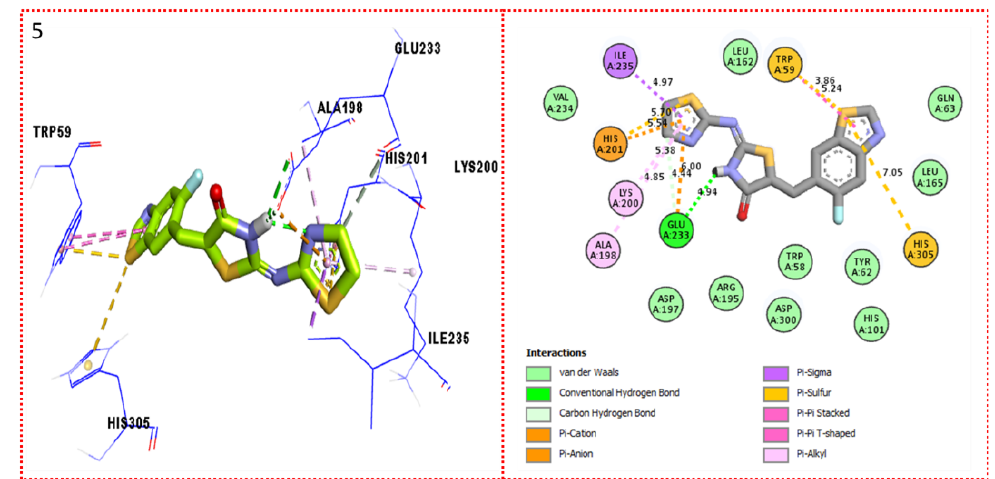
Figure 9. Protein – ligand interaction profile for active analogue against α‐ amylase represents the surface of the corresponding enzyme and indicates the PLI profile for compound 5 .